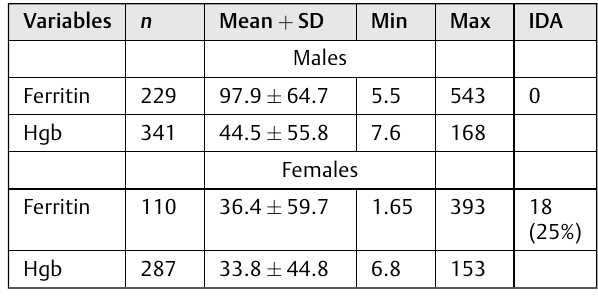
Table 4 Ferritin and Hgb per